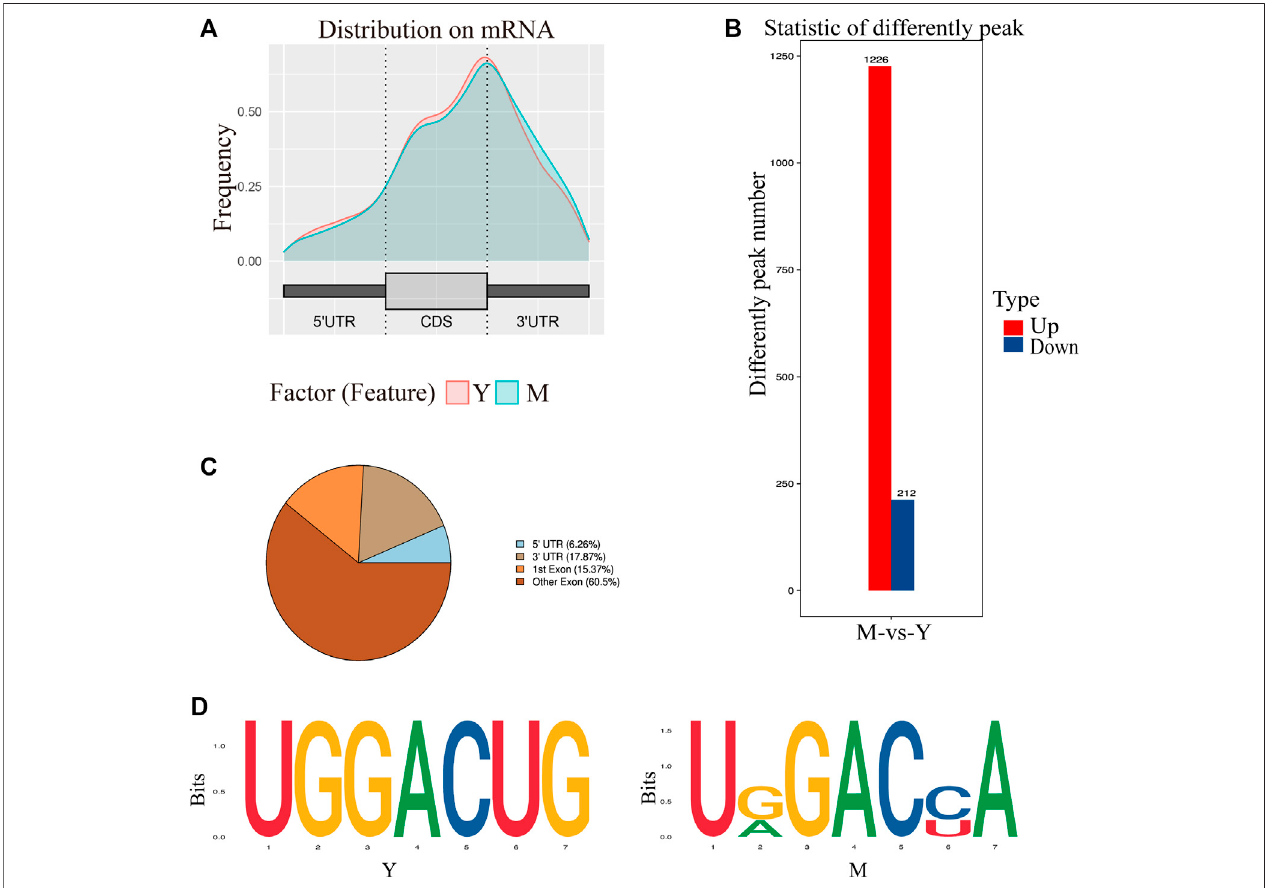
FIGURE3| Characteristics ofthem 6 Apeak. (A) Distributionofm 6 ApeakonmRNA.Thepeaksweremostlydistributedontheexonregionandtherewasadistinct enrichmentpeak atthe3 ′ terminate (nearthestop codon).Y: Before sexual maturity, M: Aftersexualmaturity. (B) Statisticalanalysisofdifferential peaks. (C) Distribution ofdifferentialmethylationpeaks onmRNA. (D) Top motifs withm 6 Apeaksin theMand Ygroups.Thisisbasedontherespectivehigh-trustpeak analysisineach group.